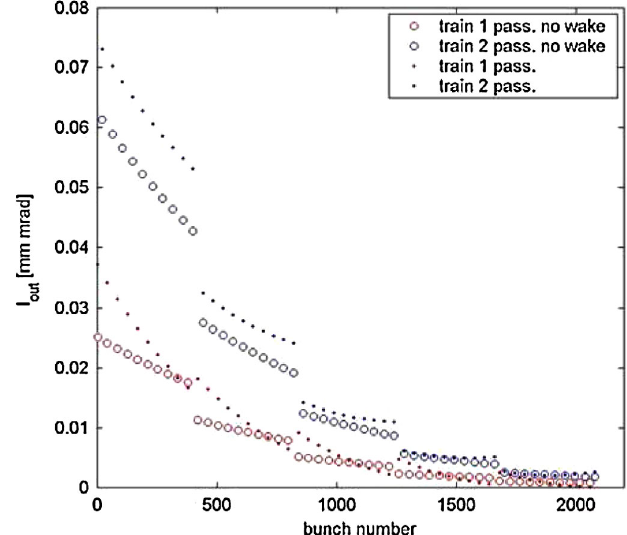
injection.FIG. 14. (Color) Output positions and angles of bunches in the case of perfect